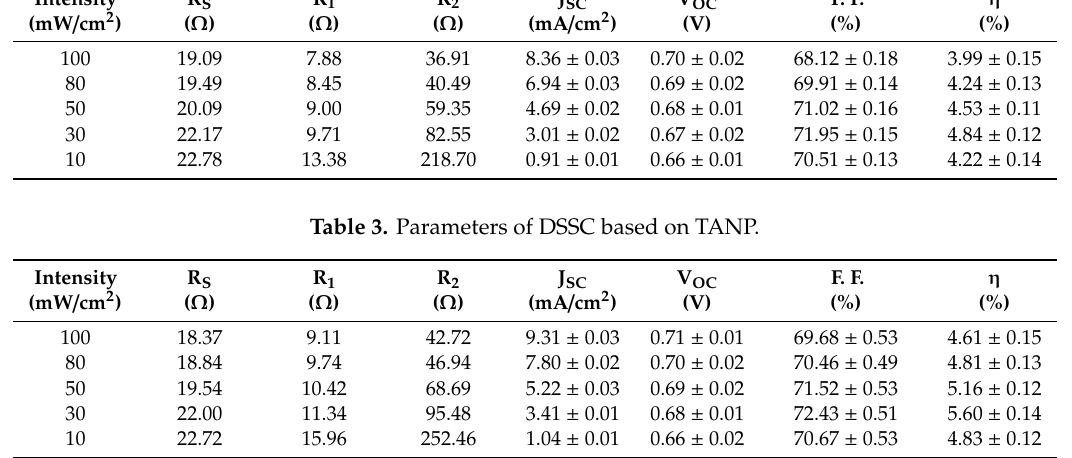
Table 2. Parameters of DSSC based on TiO 2.